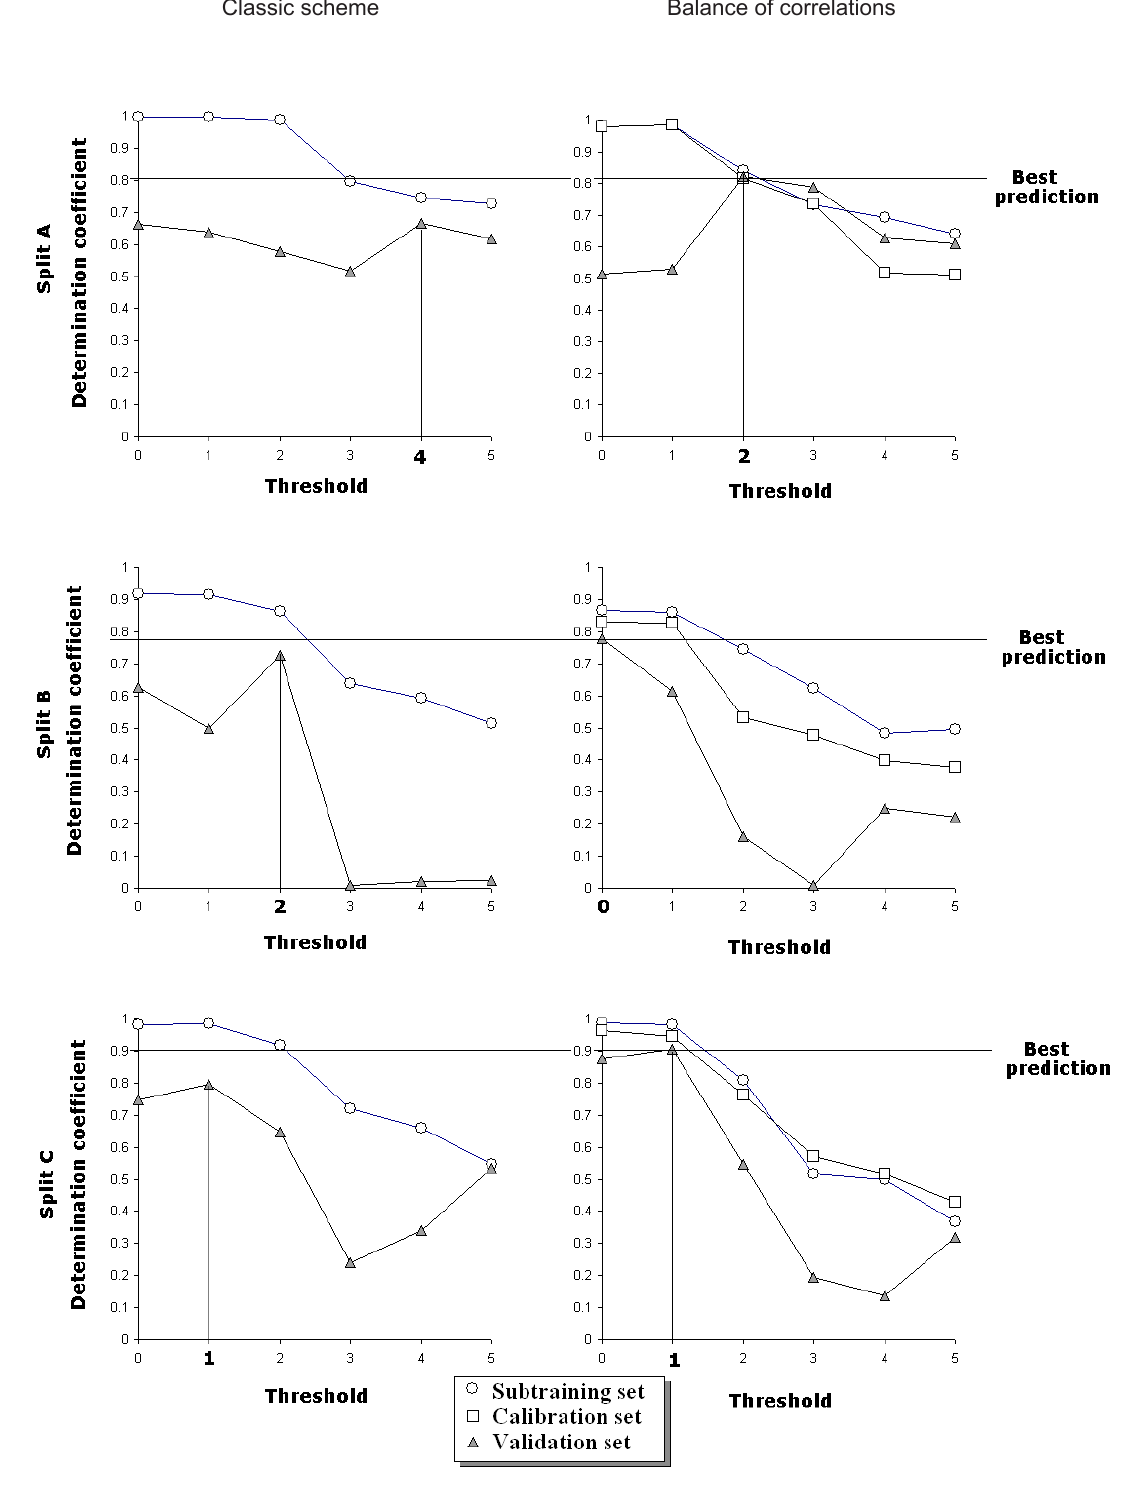
Figure 1. Determination of coefficient values which were obtained with different thresholds (0-5) for the split A, split B, and split